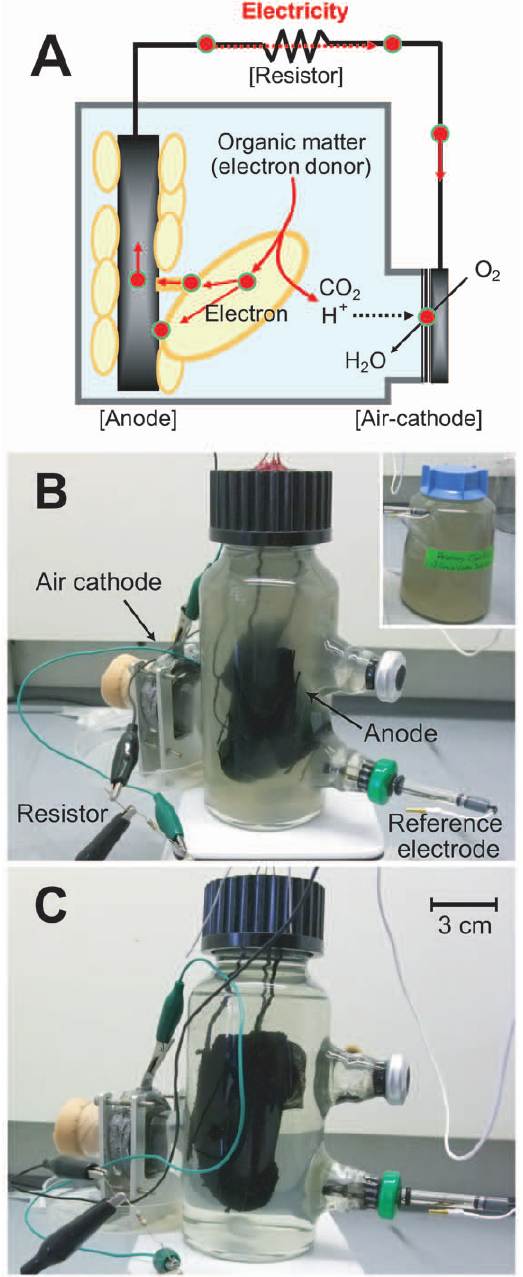
Figure 1. Microbial fuel cell (MFC) used in this study. Schematic diagram of microbial electricity generation in an air-cathode microbial fuel cell (A). The air-cathode microbial fuel cell filled with untreated primary clarifier effluent (shown in inset) (B). The microbial fuel cell after completed treatment (C). Anode and air-cathode were connected with a 750 V resistor. A Ag/AgCl reference electrode was used for linear sweep voltammetry.